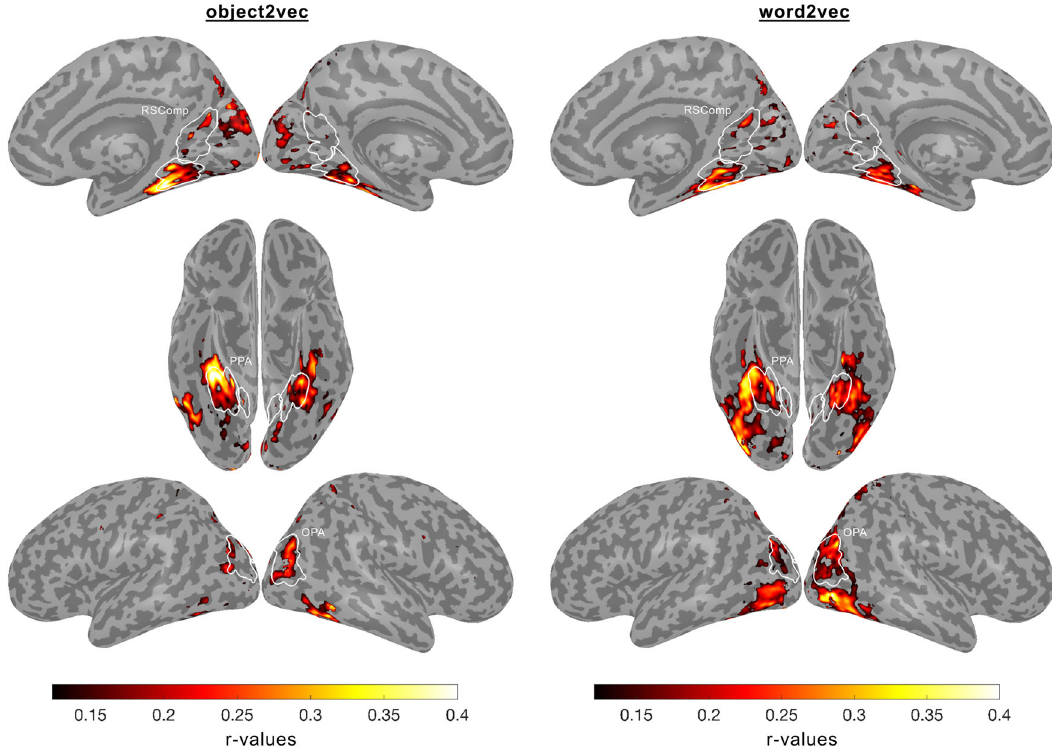
Fig. 6 Encoding models of visual and linguistic context predict fMRI responses in distinct but overlapping regions of high-level visual cortex. Voxel- wise encoding models were estimated and assessed using the 9-fold cross-validation procedure described in Fig. 3. These analyses were performed for all voxels with split-half reliability scores greater than or equal to r = 0.1841, which corresponds to a one-sided, uncorrected p -value of 0.05 (see split-half reliability mask in Supplementary Fig. 8). Encoding model accuracy scores are plotted for voxels that show signi fi cant effects ( p < 0.05, FDR-corrected, one-sided permutation test). The left panel shows prediction accuracy for the image-based object2vec encoding model, and the right panel shows prediction accuracy for the language-based word2vec encoding model. There is a cluster of high prediction accuracy for the object2vec model overlapping with the anterior portion of the PPA, mostly in the right hemisphere. There are also several other smaller clusters of signi fi cant prediction accuracy throughout high-level visual cortex, including clusters in the OPA and RSComp. The word2vec model produced a cluster of high prediction accuracy that partially overlapped with the signi fi cant voxels for the object2vec model in the right PPA but extended into a more lateral portion of ventral temporal cortex as well as the lateral occipital cortex. ROI parcels are shown for scene-selective ROIs. PPA parahippocampal place area, OPA occipital place area, RSComp retrosplenial